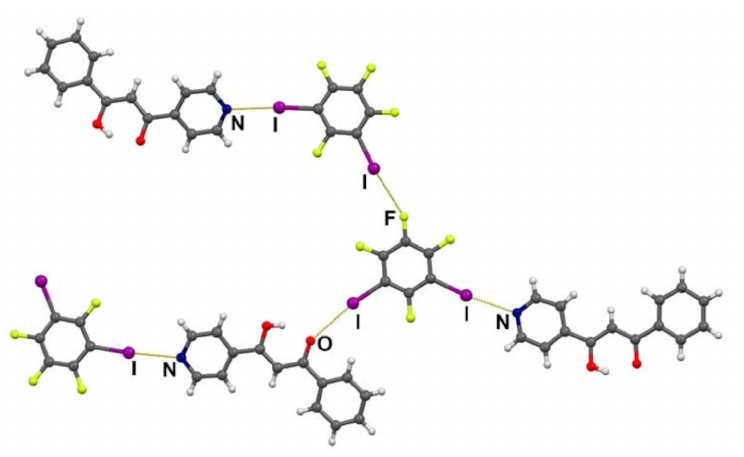
Figure 5. Supramolecular hexamer interconnected by I ··· N, I ··· O, I ··· F and I ··· I halogen bonds in ( b4pm )( 13tfib ). Hydroxyl hydrogen atoms were placed on calculated positions with respect to the lengths of C–O